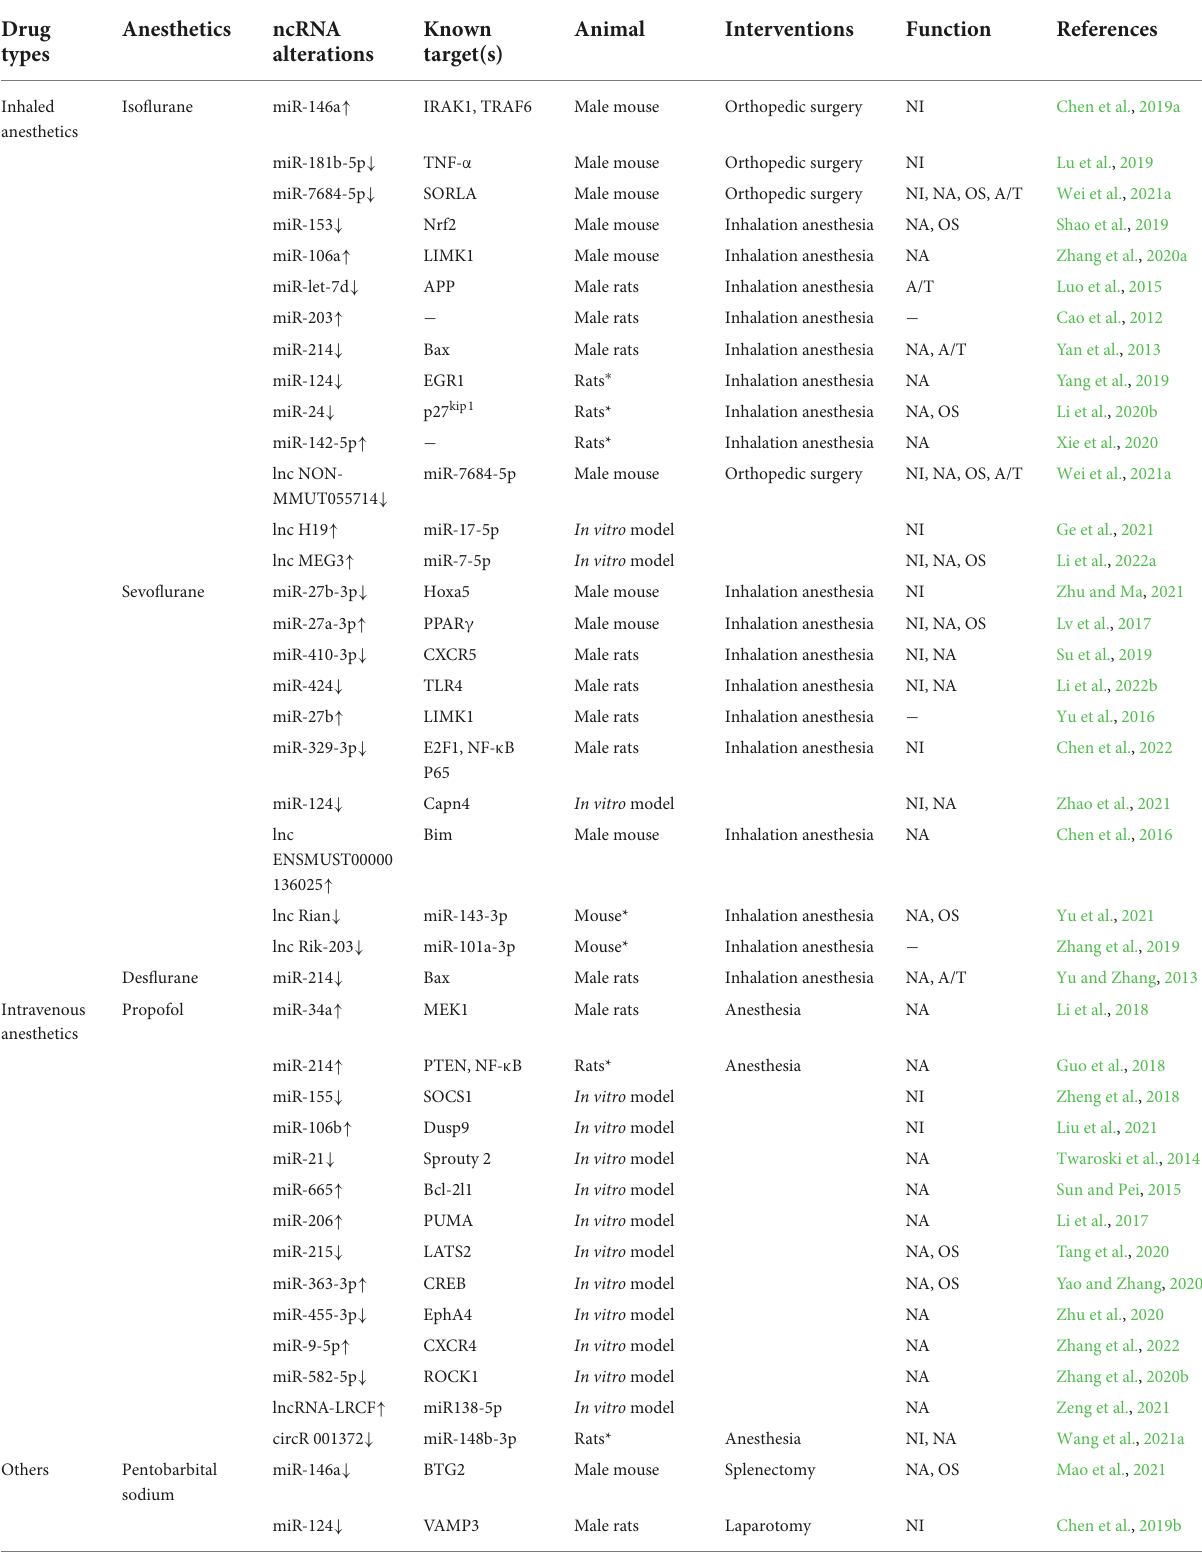
TABLE 2 The anesthetics and/or surgery-specific ncRNAs alterations and their targets in POCD. Drug